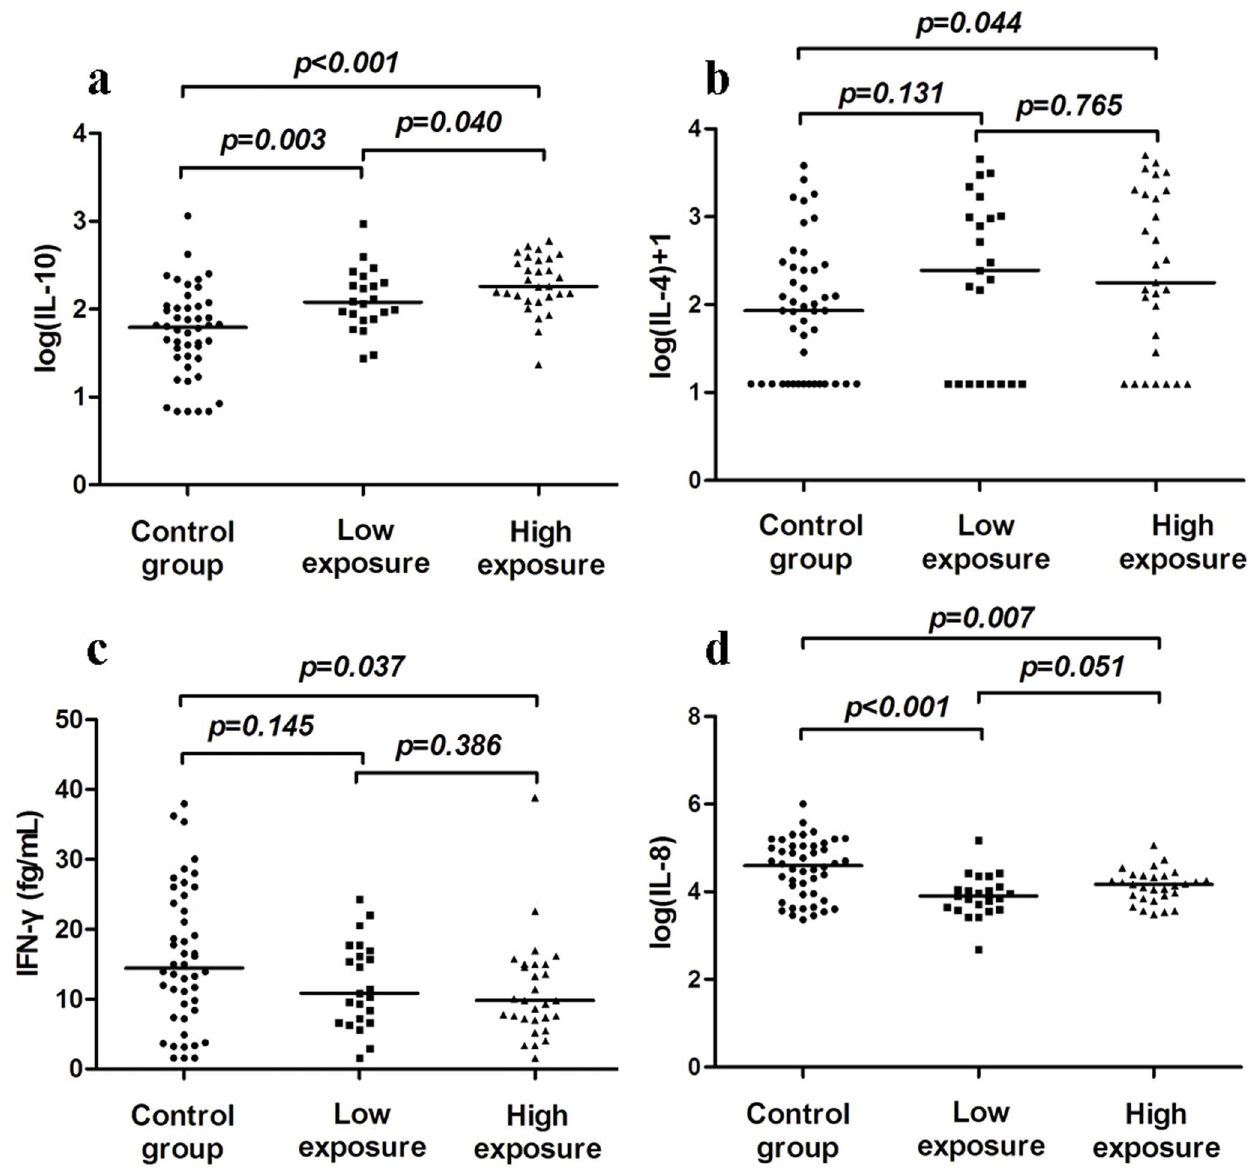
Figure 3. Comparison of serum cytokine levels between FA-exposed workers (n=23 in the low exposure group and n=29 in the high exposure group) and the non-exposed controls (n=46). Serum levels of IL-10 (a), IL-4 (b), IFN- c (c), and IL-8 (d) were measured by multiplexed bead immunoassay. Mann–Whitney U-test was performed to compare FA-exposed workers with the control.